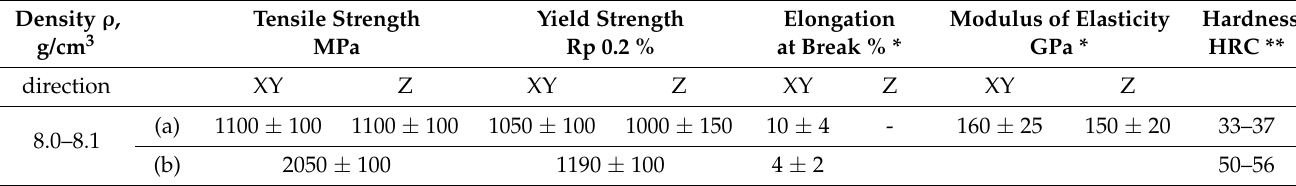
Yield Strength Rp 0.2 %